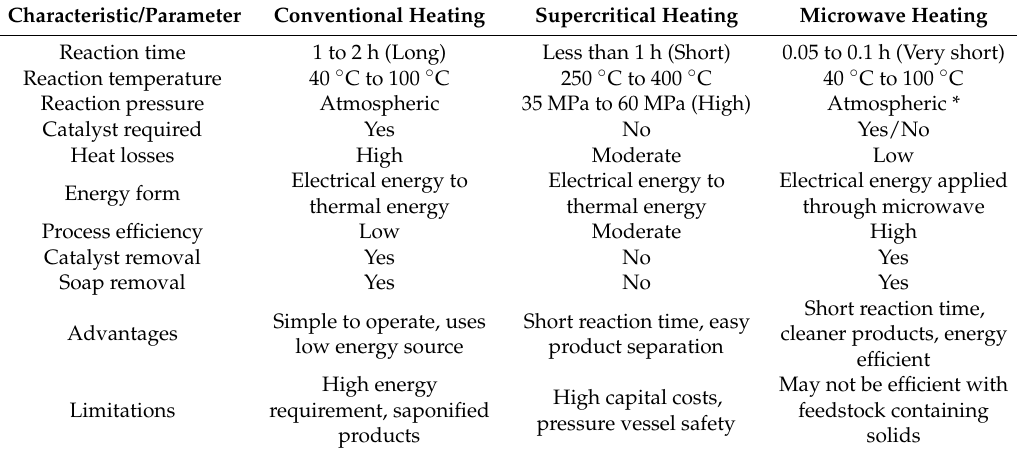
Table 2. Comparison between three types of heating methods for biodiesel